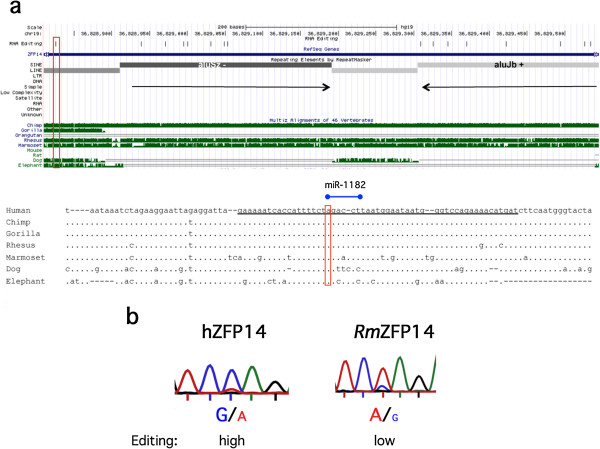
Inverted Alu elements and site-selective editing in ZFP14. (a) Top: UCSC genome browser view. Inverted Alu elements are annotated with their family and strandedness in the repetitive elements by RepeatMasker track, and marked with black arrows. (b) Reverse strand Sanger sequencing after RT-PCR on ZFP14 transcripts from human (hZFP14) and rhesus (RmZFP14) brain. Editing is detected as a dual A and G peak in the chromatograms.